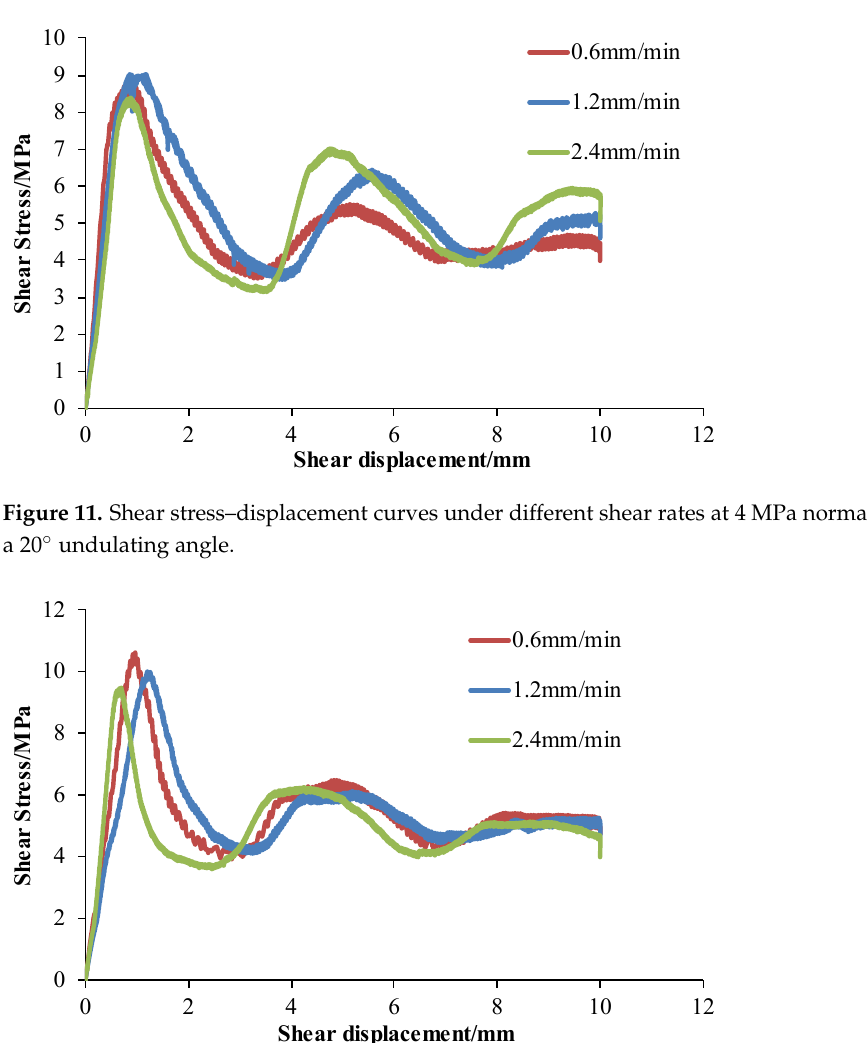
Figure 10. Shear stress–displacement curves under different shear rates at 4 MPa normal stress with a 10° undulating angle.